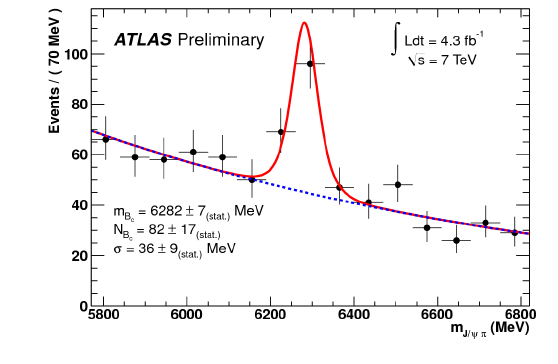
Figure 13: The invariant mass distribution of reconstructed B ± c → J /ψπ ± candidates.